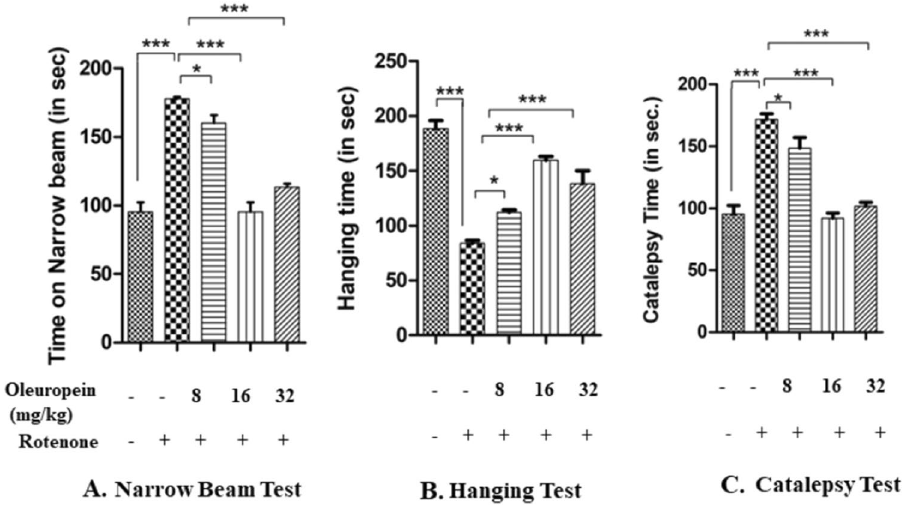
Figure 1. Effect of different doses of OLE on behavioural parameters in rotenone-induced mouse model. Narrow Beam Test showed increase in narrow beam walking time in rotenone group (***p < 0.001) as compared to the control group. Whereas, after the treatment with OLE (16 and 32 mg/kg bwt), the walking time of mice to cross the beam was significantly decreased (***p < 0.001). Hanging test presented decrease in hanging time in rotenone intoxicated mice as compared to control(***p < 0.001) whereas, in OLE treated group (16 and 32 mg/ kg bwt), hanging time was significantly reduced (***p < 0.001). Catalepsy Test exhibited the reduced latency time to change its unusual posture was associated with rotenone induced mice (***p < 0.001) than control. While, significant decrease in catalepsy was observed in OLE treated mice (16 and 32 mg/kg bwt) (***p < 0.001).In all these three behavioural parameters, the OLE doses of 8 mg/kg bwt. showed a less significant effect. (*p < 0.05). The one-way ANOVA was used to analyse the data, followed by the Newman-Keuls test. The mean ± SEM (n = 6) is used to depict the